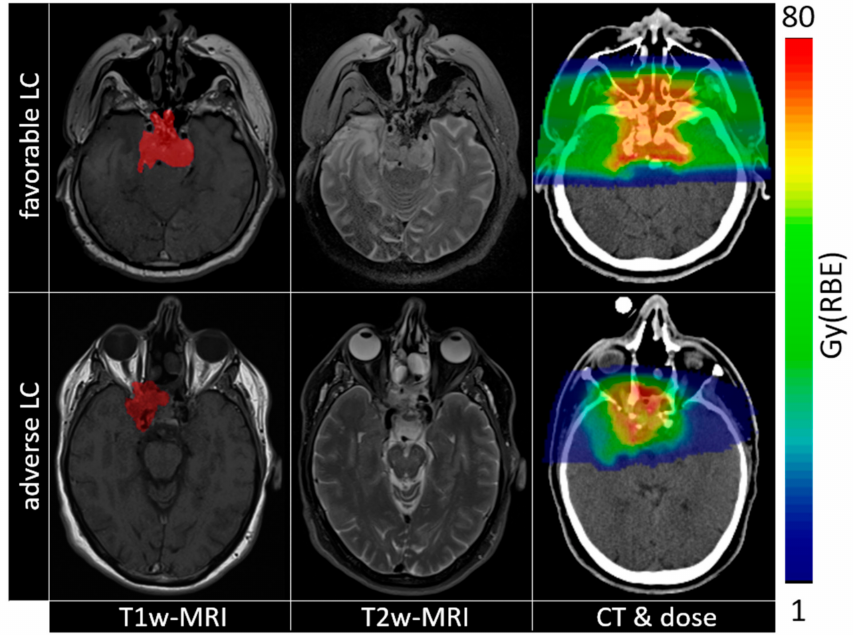
Figure 3. Imaging (from left to right: T1w-MRI, T2w-MRI, CT) and dose maps (overlaid to CT) for patients with opposite local control evaluation (top row favourable LC, bottom row adverse LC). Tumour contours are shown as red overlays on T1w-MRI